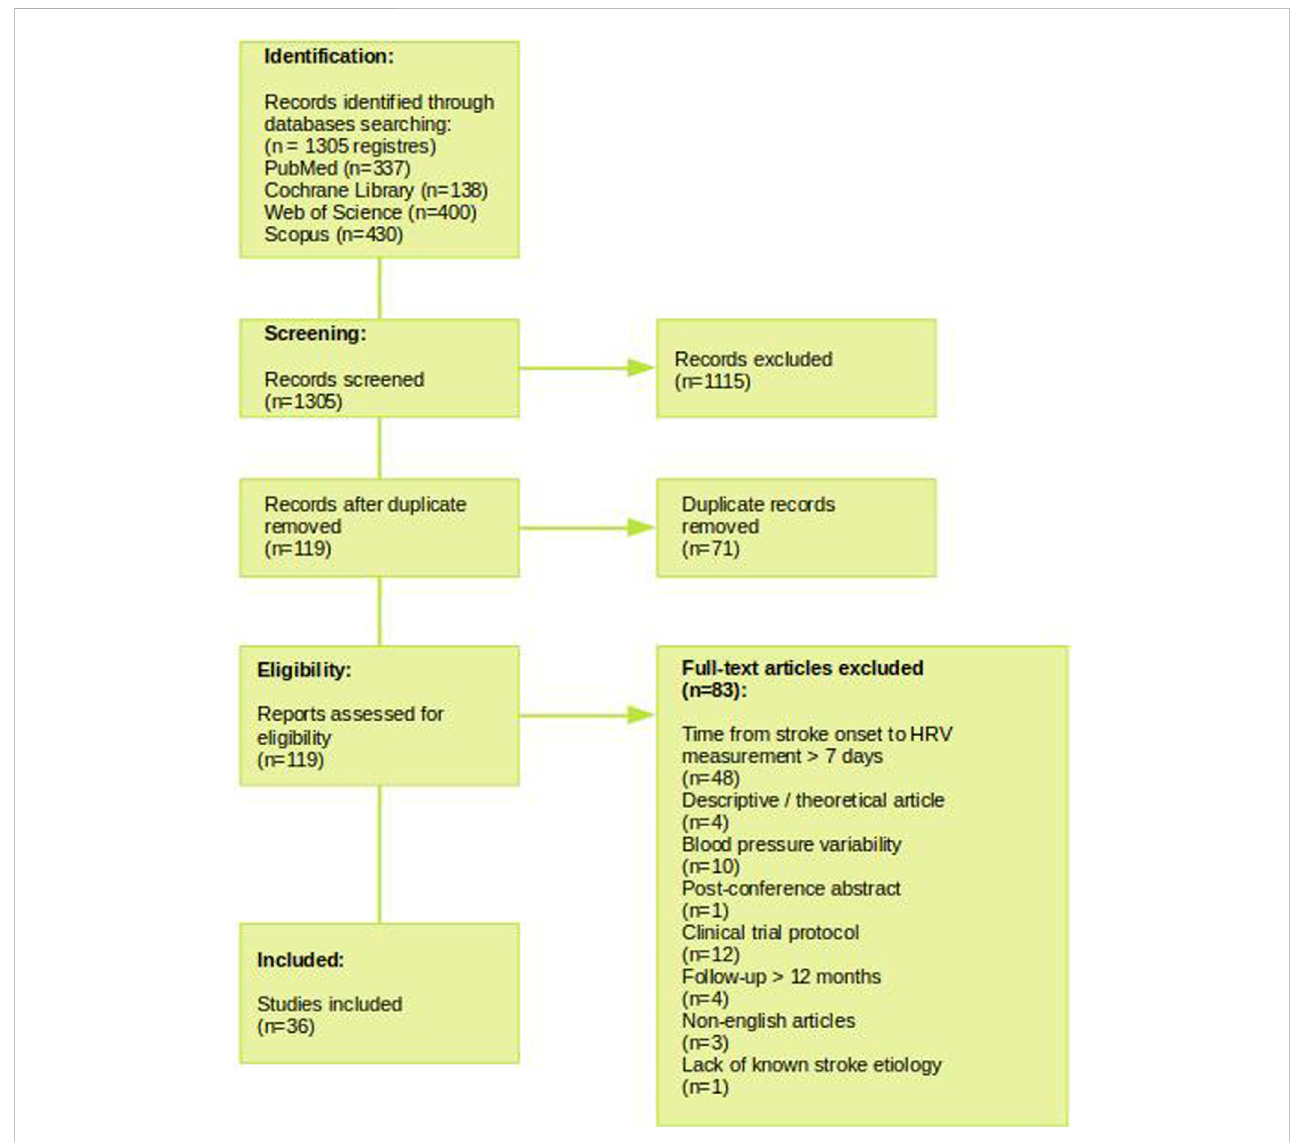
FIGURE 1 Flow chart for study search and selection methods according to the PRISMA